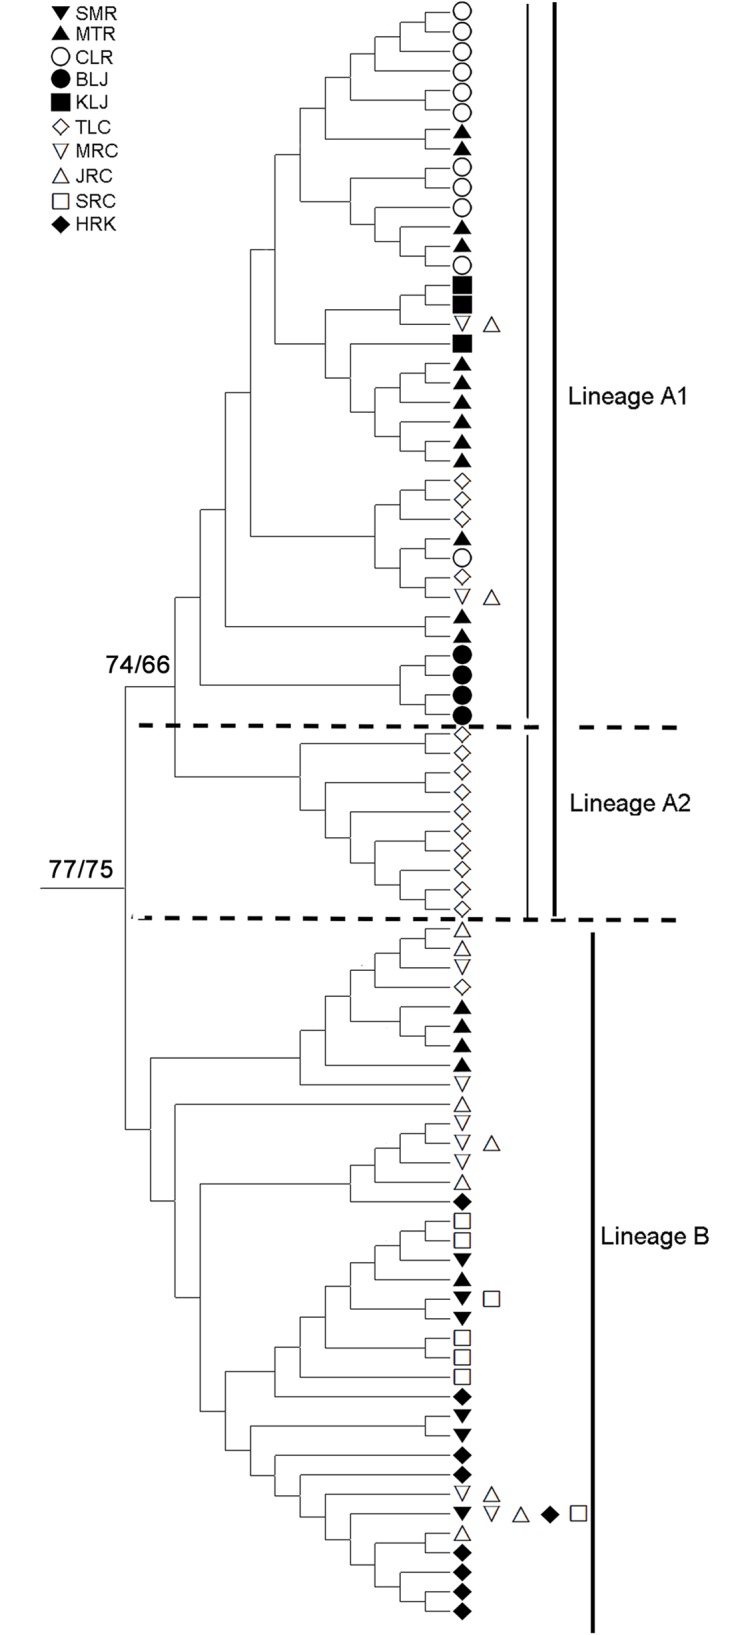
Neighbour-Joining (NJ) tree based on mtDNA 16S rRNA and COI sequences with bootstrap values (NJ/ML, respectively) shown adjacent to the corresponding two lineages for Macrobrachium nipponense.The numbers at the nodes indicate bootstrap values (expressed as percentage) with 1,000 replicates.